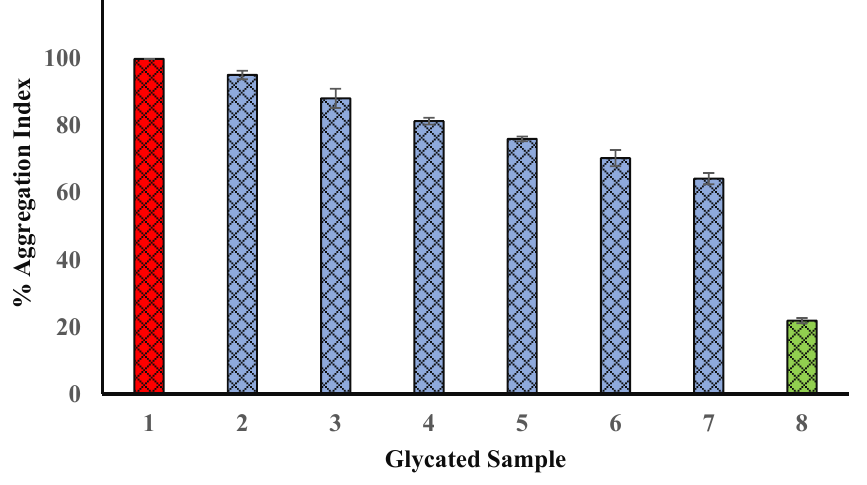
Figure 10. Reduction in percent of aggregation in presence of Ajwa seed methanol extract. Sample 1 (red column) belongs to BSA kept with glucose for 15 days (100% aggregation). Bars 2, 3, 4, 5, 6, and 7 show percent of aggregation of glycated samples with 100, 200, 300, 400, 500, and 600 µ g/mL of Ajwa seed extract (blue columns), and the percent of aggregation (the degree of glycation) was found to be decreased with an increase in the concentration of seed extract. Bar 8 (green column) shows the percent aggregation of BSA incubated in the absence of any extract or glucose, and exhibited the least aggregation (glycation). The results are presented as means ± SEM ( n = 3, p < 0.05).